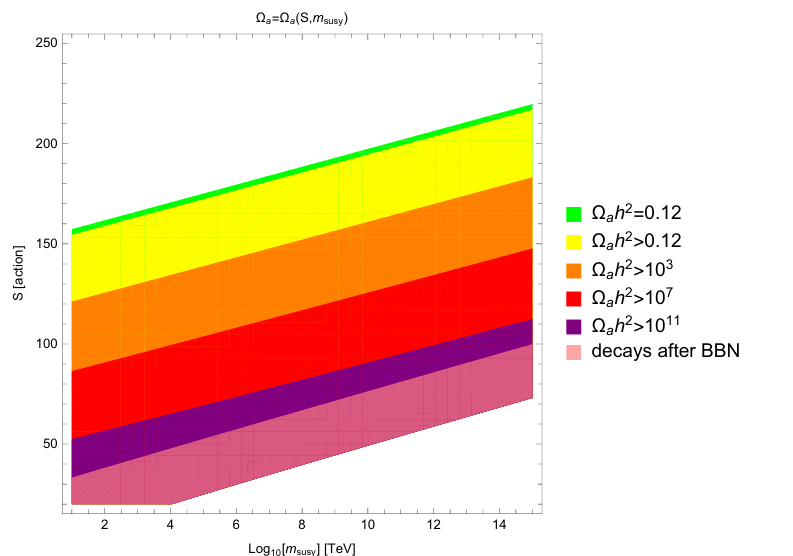
Figure 1 . Relic abundance as a function of the action S and the SUSY breaking scale m susy for a single geometric axion. Instanton actions below S ∼ 150 tend to overproduce axions and, depending on the SUSY breaking scale, the required tuning can be severe. The tuning in the initial condition √ to compensate the overabundance goes as θ 1 / Ω . As expected, each axion suffers of this tun ∼ a problem individually, resulting requiring a huge tuning if the number of axions is n > O (10) . In the region above the thin, green band axions compose a subdominant part of the DM. Assuming a decay contant around the GUT scale, F , in the shaded pink region the axion decays a ∼ M GUT between BBN and today, spoiling the success of nucleosynthesis. Below this region, axions decay before BBN and are in principle cosmologically